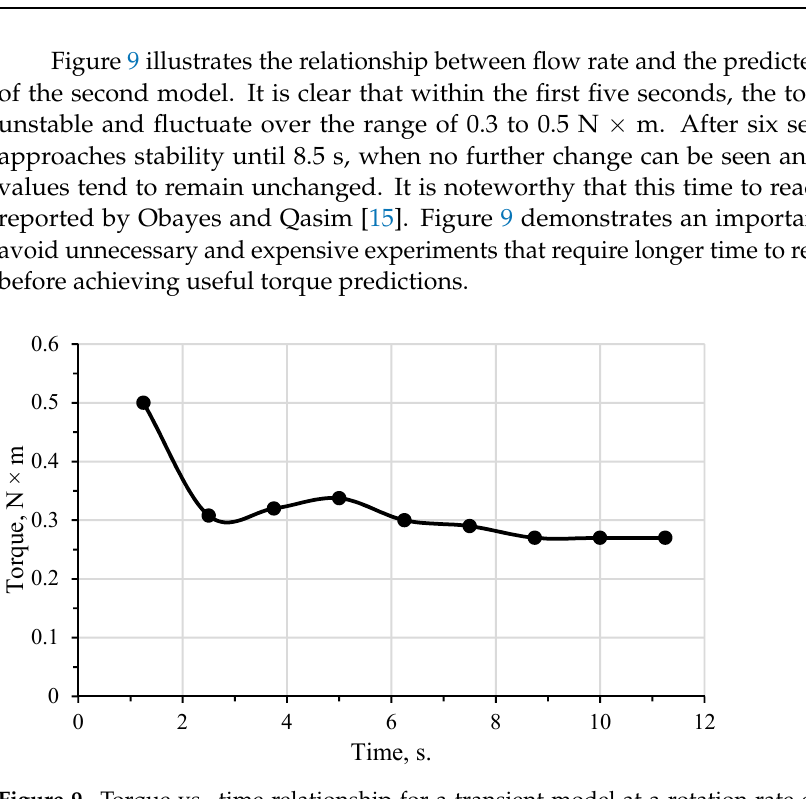
Figure 9. Torque vs. time relationship for a transient model at a rotation rate of 24.5 rad/s and 0.05 m/s inlet velocity.